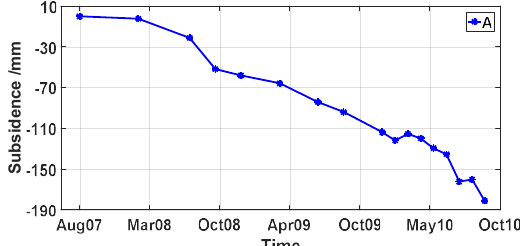
Figure 6. Surface subsidence time series with respect to PS point labeled as A in Figure 4